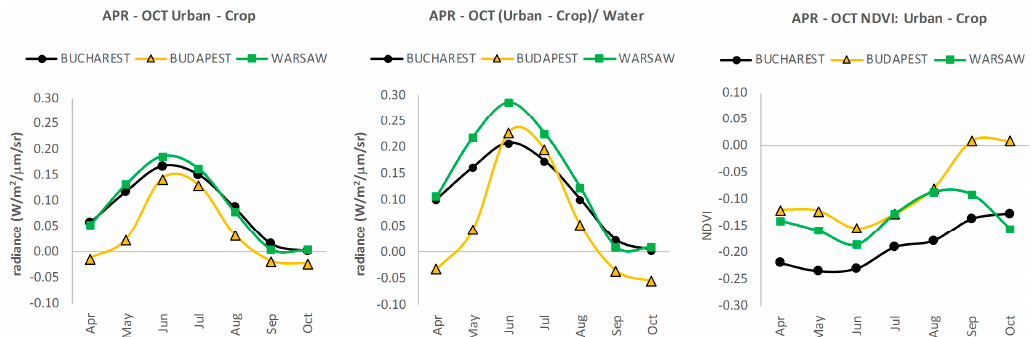
Figure 6. Simple differences in mean MIR radiance between urban and cropland classes ( left ); Normalized differences in mean MIR radiance between urban and cropland classes ( middle ); Simple differences in mean NDVI between urban and cropland classes ( right ).